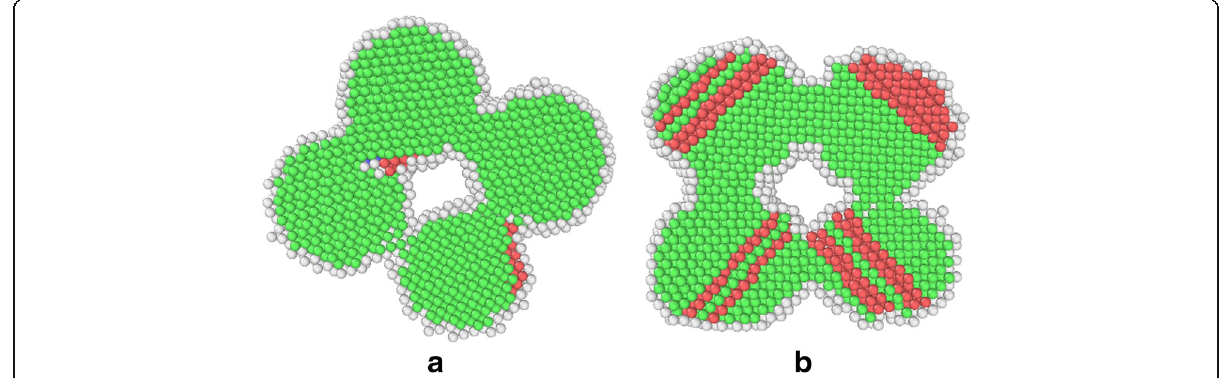
Fig. 7 Nanostructure of the solid state sintered silver nanoparticles. a Without system vibration. b With system